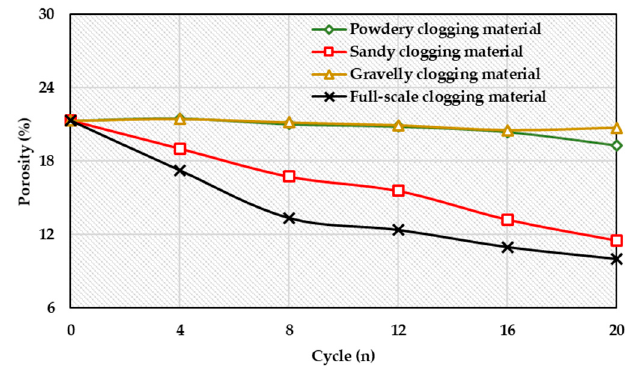
Figure 14. Porosity of COF-OGFC with different clogging materials.